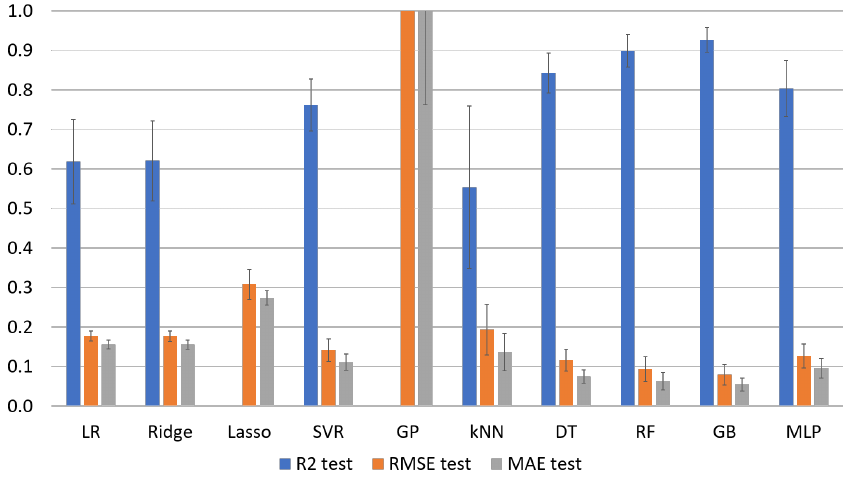
Figure 11. Test performances of the ten screened ML models (without HP